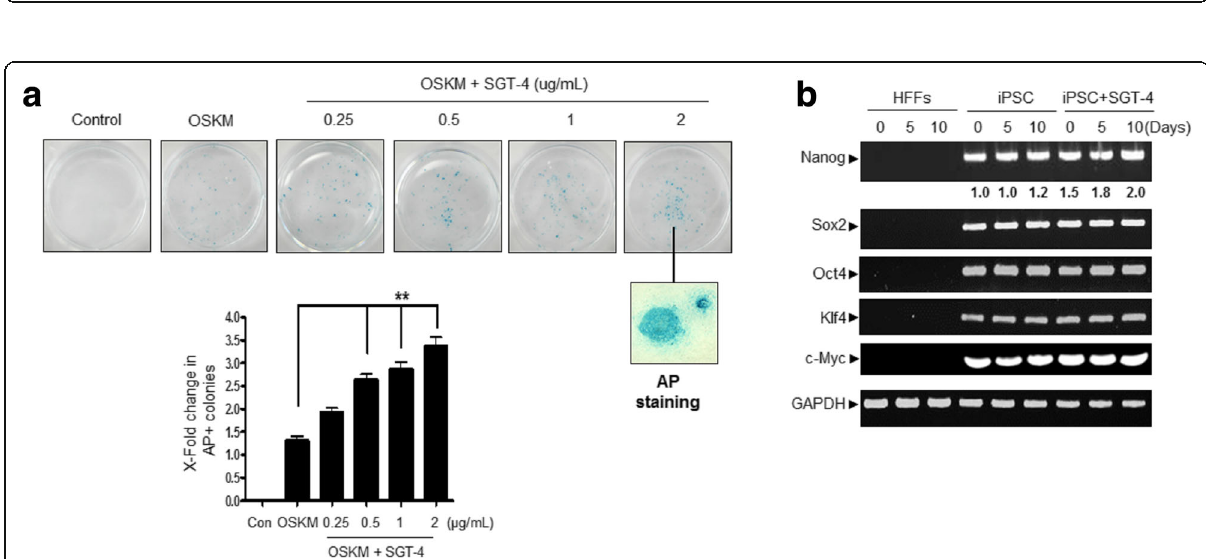
Fig. 4 hiPSCs have an ES cell-like property. a Representative pictures of hiPSCs line derived in the presence of SGT-4. hiPSCs lines derived from 4F reprogramming in the presence of SGT-4 were cultured in ES cells medium on Matrigel-coated plates in the absence of feeder cells. The diagram shows the comparison of the number of AP+ colonies generated from HFFs. Each value is expressed as the mean ± SD ( n = 3). ** P < 0.01 indicates a significant difference versus OSKM treatment alone. b RT-PCR demonstrating that three randomly selected 4F HFF-derived iPSCs express the pluripotent marker genes Nanog, c-Myc, Sox-2, Oct4, and